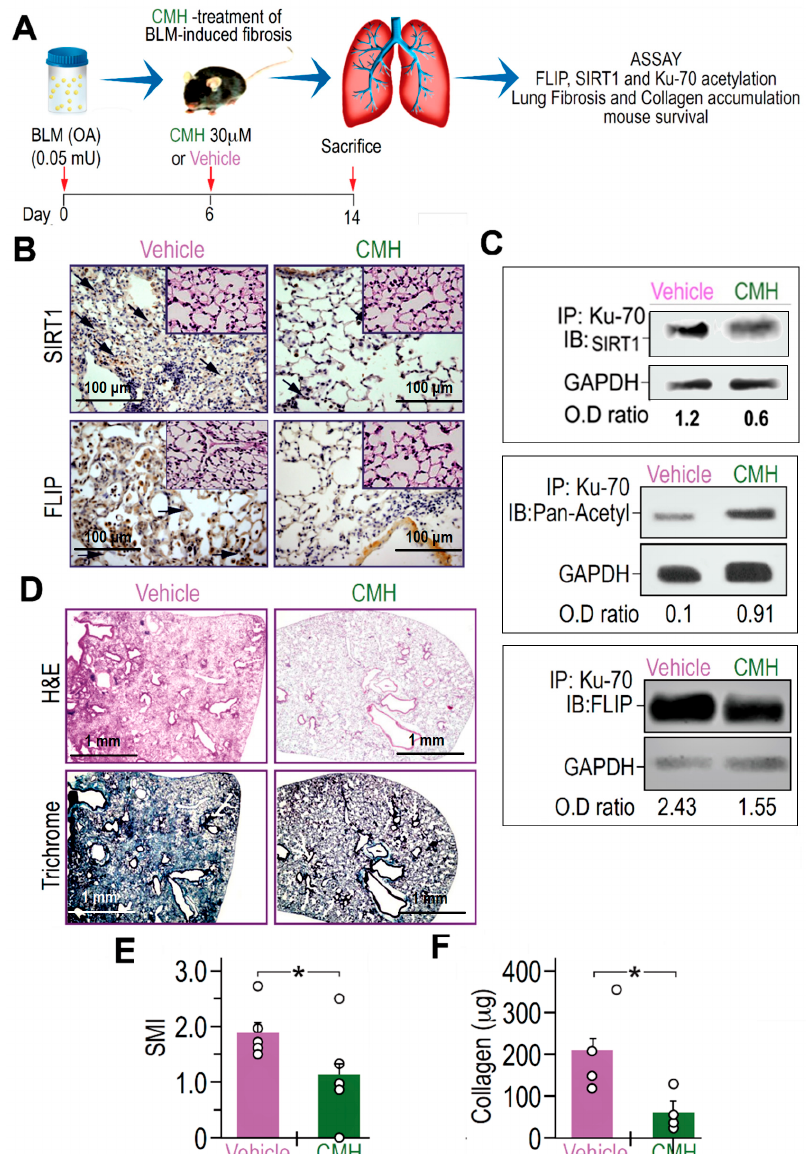
Figure 4. CMH downregulates FLIP, increases Ku70 acetylation, decreases Ku70/FLIP complex, and attenuates fibrosis, in bleomycin (BLM)-treated WT mouse lungs. ( A ) Schematic presentation of CMH administration into BLM-treated (0.05 mU) C57BL/6 WT mice. On day 6 after BLM, each mouse was further treated with 30 µM CMH or control 4% DMSO (vehicle) and sacrificed at day 14 post-BLM. ( B ) Immunohistochemistry (IHC) of lung SIRT1 and FLIP expression (×20 and ×40 inserts), marked by arrows in upper and lower panels, respectively. Lung fibroblast Ku70-IP and IB of ( C ) SIRT1, pan- acetyl, and FLIP ( n = 5). ( D ) IHC of H&E and trichrome staining in lung tissue sections (upper and lower panels). ( E ) Semi-quantitative morphology index (SMI) grading lung pathology and ( F ) collagen Sircoll assay. Representative of two experiments. n = 4–5. * p < 0.02.